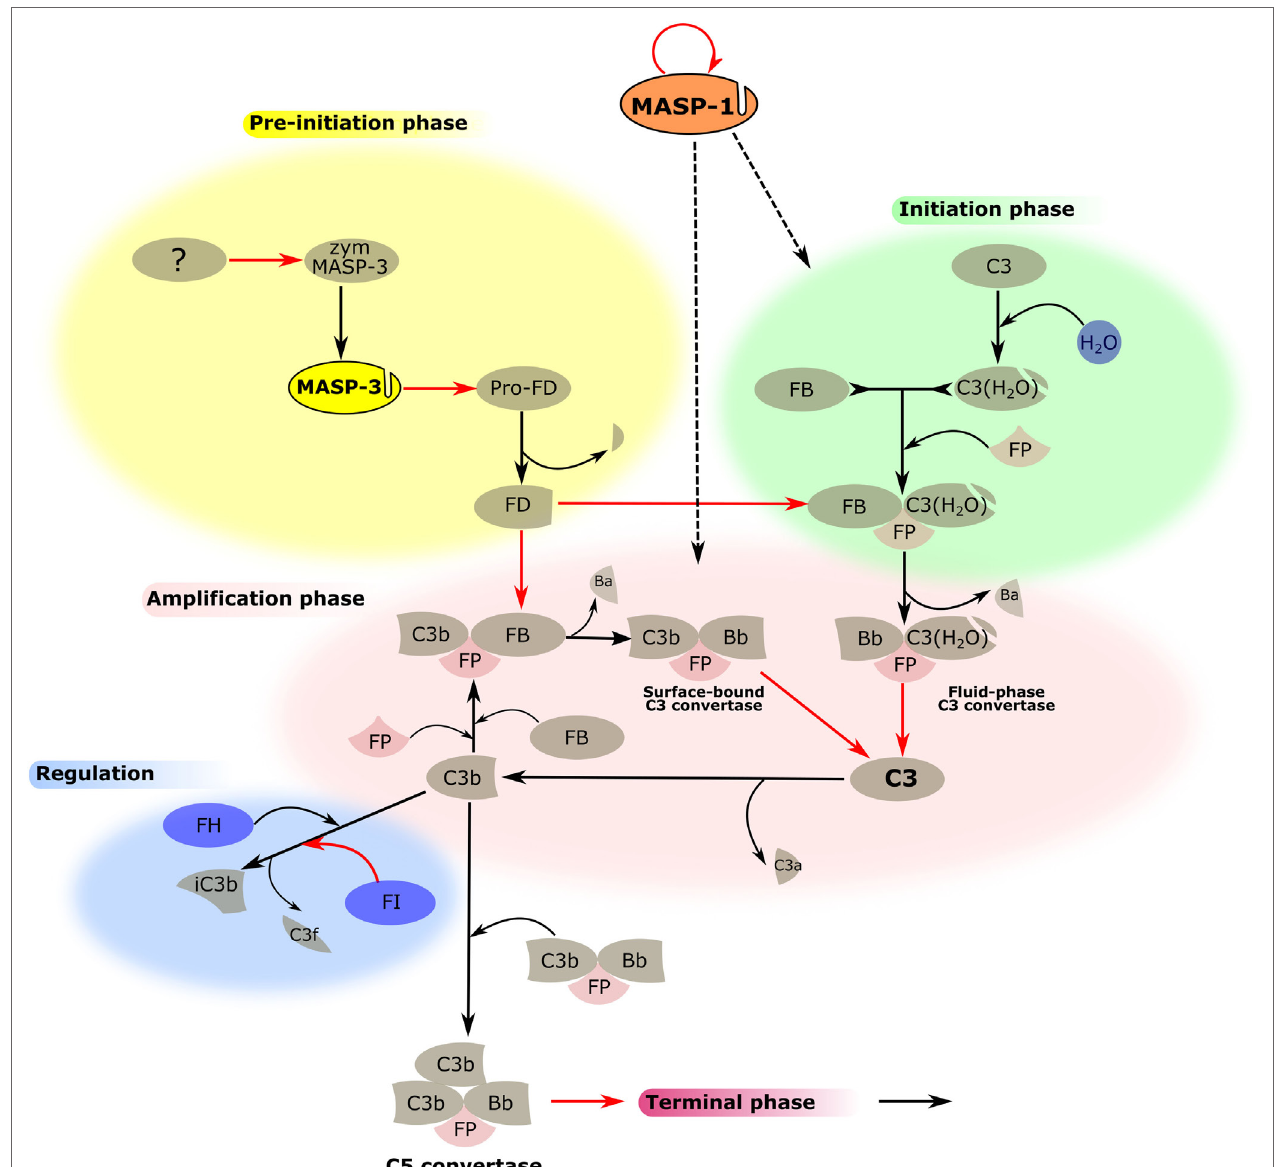
FiGURe 3 | MASP-1 and MASP-3 play roles in the activation of the alternative pathway (AP). The activation process of the AP is divided into several phases, which are indicated by differently colored backgrounds. MASP-3 is proved to be the professional activator of pro-factor D in blood, therefore, plays an important role in the pre-initiation phase. The physiological activator of zymogen MASP-3 (zym MASP-3) is hitherto undiscovered (shown by the question mark). MASP-1 is indispensable for efficient initiation and amplification of the AP on certain surfaces, although the mechanism is yet unknown (shown by dashed arrows). Black arrows represent conversion processes, while red arrows stand for enzymatic reactions pointing from the enzyme toward its substrate. The circle-shaped red arrow symbolizes the autoactivation of